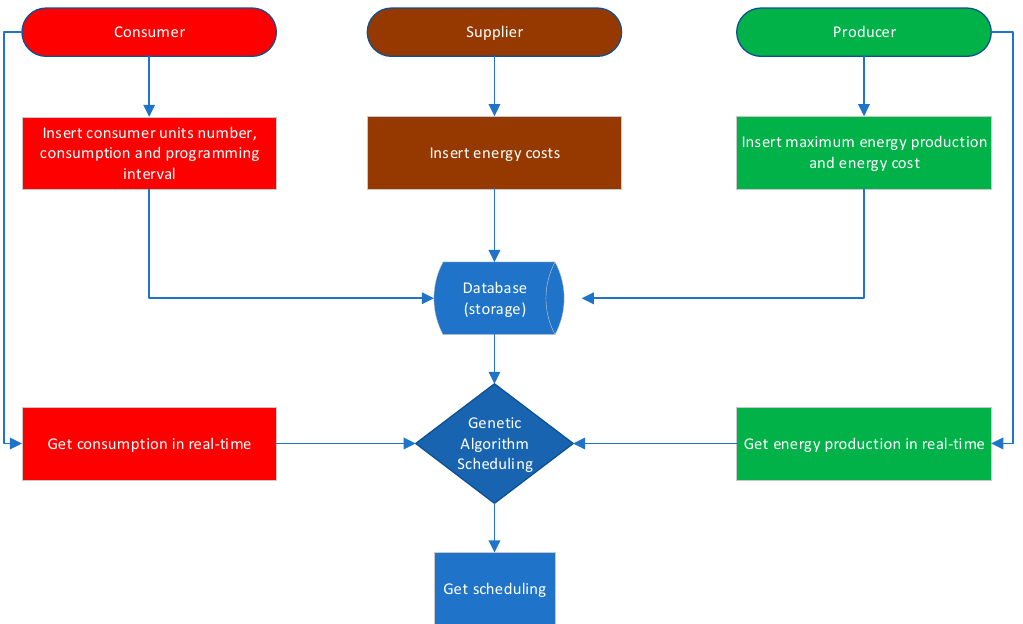
Figure 4. Planning flow for consumer, producer, and supplier. The supplier must enter only the cost of electricity (which can be taken from electricity bills). The producer must enter its maximum production capacity and cost of energy produced (which can be taken from the specifications of the energy source) and electricity produced at some point (which can be given by the controller). The consumer must enter the number of consumption units, the programming interval, and the consumption at a given time using a current consumption monitoring system.